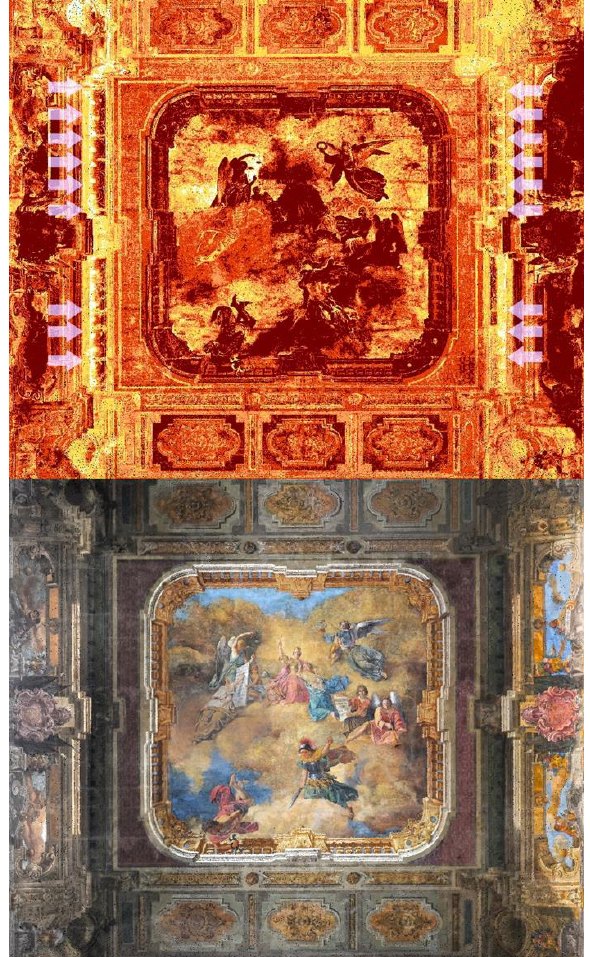
Figure 9. Comparison between colored point cloud with reflection data and RGB